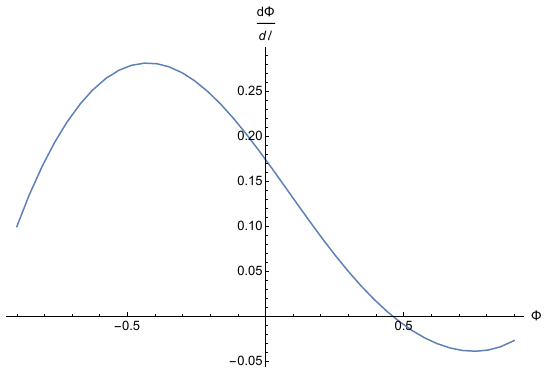
Figure 4 . An evaluation of the RG flow of Φ , showing a stable fixed point at Φ c ≈ 0 . 46